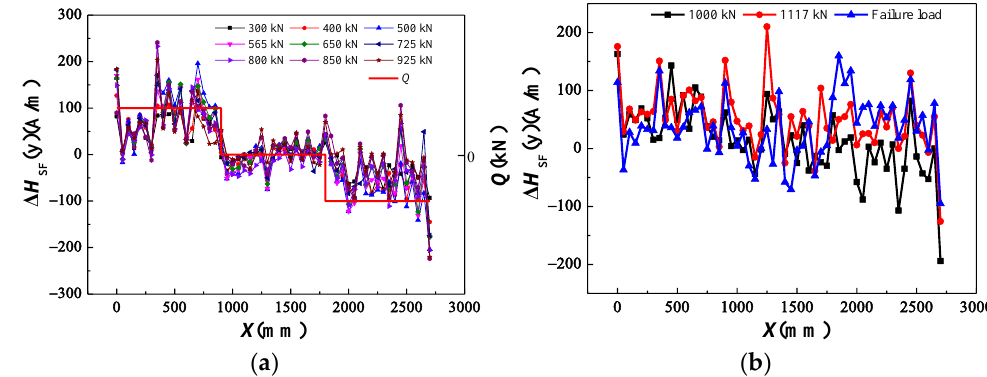
Figure 12. ∆𝐻 SF (y) curves of the web: ( a ) elastic and elastoplastic loading stages; ( b ) plastic